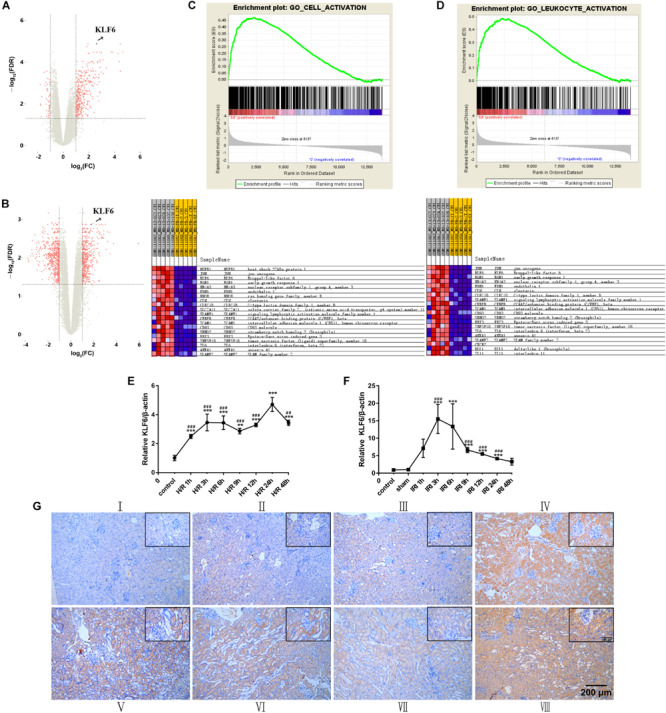
KLF6 expression in IRI and its biological function were predicted by bioinformatic analysis and verified experimentally. (A,B) Volcano plot illustrating the differentially expressed proteins identified by quantitative analysis. The –log10 (P-value) was plotted against the log2 (IR/Control) ratio. The red dots represent proteins with dysregulated expression in IR samples, and the blue dots indicate KLF6 upregulation in IR samples. (C,D) GSEA of microarray data showing enrichment plots and beat maps for sets of genes in the GSE58438 dataset involved in cell activation, leukocyte activation. (C) Enrichment plot for the cell activation gene set. Heat map of the core enriched genes in the cell activation gene set. (D) Enrichment plot for the leukocyte activation gene set. Heat map of the core enriched genes involved in leukocyte activation. In the enrichment plot, a positive enrichment score (ES; red part of the horizontal bar) indicates gene set enrichment at the top of the ranked list. A negative ES (blue part of the horizontal bar) indicates gene set enrichment at the bottom of the ranked list The middle part of the plot shows the positions of the genes in the gene ranking list. The bottom portion or the plot shows the value of the ranking metric with decreasing rank. Heat map of correlation values for all individual genes within the gene set. The colors and shades indicate the direction and magnitude of correlation. The red boxes indicates a positive correlation with IRI, and the blue boxes indicates a negative correlation with IRI. Darker shades correspond to larger correlation values. The set of genes with the greatest contribution to the ES, i.e., the leading edge subset of genes, is enclosed in a box in both the enrichment plot and the heat map. (E,F) Time course of the expression levels of KLF6 in mouse kidneys and HK-2 cells. Tissues were harvested at different time points after the bilateral renal pedicle was clamped for 45 min. In vitro, total RNA samples were extracted for RT-PCR, showing significant induction of KLF6 alter hypoxia for 24 h/reoxygenation for 3 h (n = 5 per group). (G) The localization of KLF6 in the mouse kidney after IRI (45 min of bilateral renal ischemia followed by 24 h of reperfusion) was detected by immunohistochemistry. Positive staining of formalin-fixed, paraffin-embedded mouse kidney sections is indicated by the yellow–brown color. Scale bar, 200 μm. (I: control; II: sham; III: AAV-miR-181d-5p; IV: AAV-shRNA; V: I/R; VI: I/R+AAV-control; VII: I/R+AAV-miR-181d-5p; VIM: IRI+AAV-shRNA.) The data arc presented as the means ± SDs. *P < 0.05, **P < 0.01, ***P < 0.001.